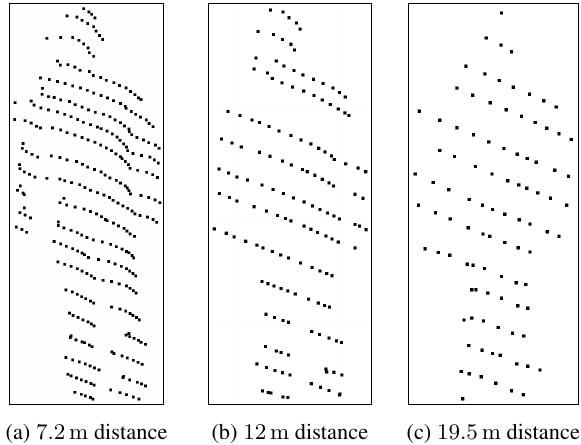
Figure 1. Person in a single scan of a Velodyne HDL-64E LiDAR in different